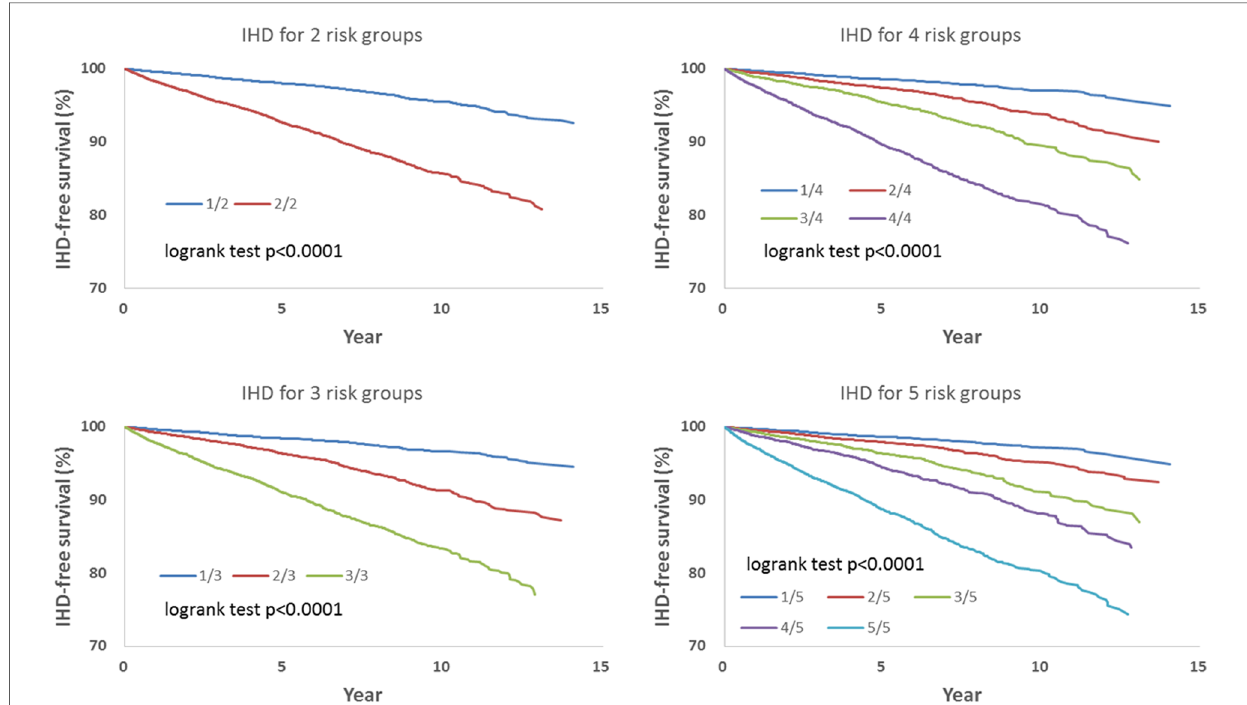
FIGURE 3 Based on Tables 2 , 3 , the hazard-based risk grouping effectively strati fi ed irradiated breast cancer patients in the endpoint of ischemic heart disease (IHD, p <0.0001 in all sub-grouping). Note that the each patient ’ s individual hazard is estimated according to Table 2 . According to the order of the individual hazard, all included patients were allocated equally in number into 2, 3, 4, or 5 sub-groups based on parameters including all covariates and socioeconomic variables showed in Table 2 to assess the risks of IHD, OHD, and HF.